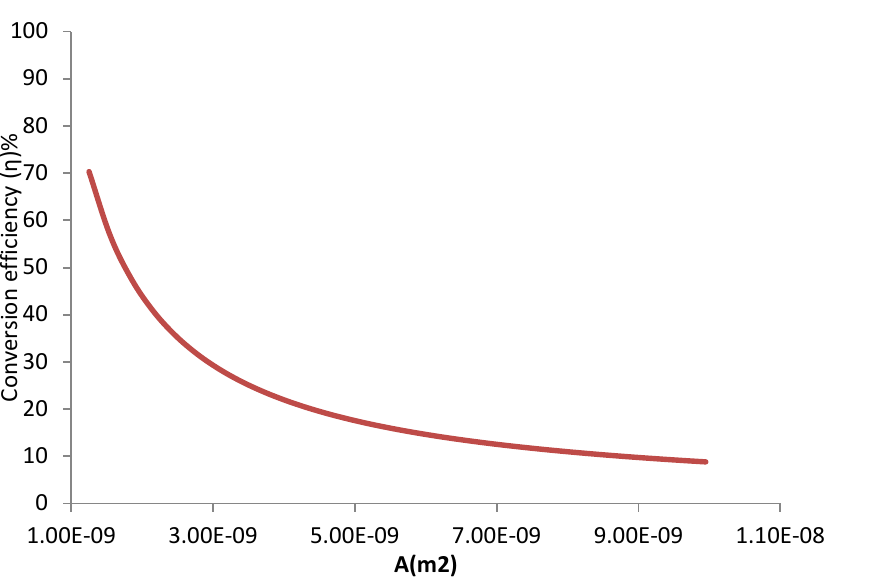
Fig. 7: Conversion efficiency vs. cross section area (m 2 ) of laser spot at RT.